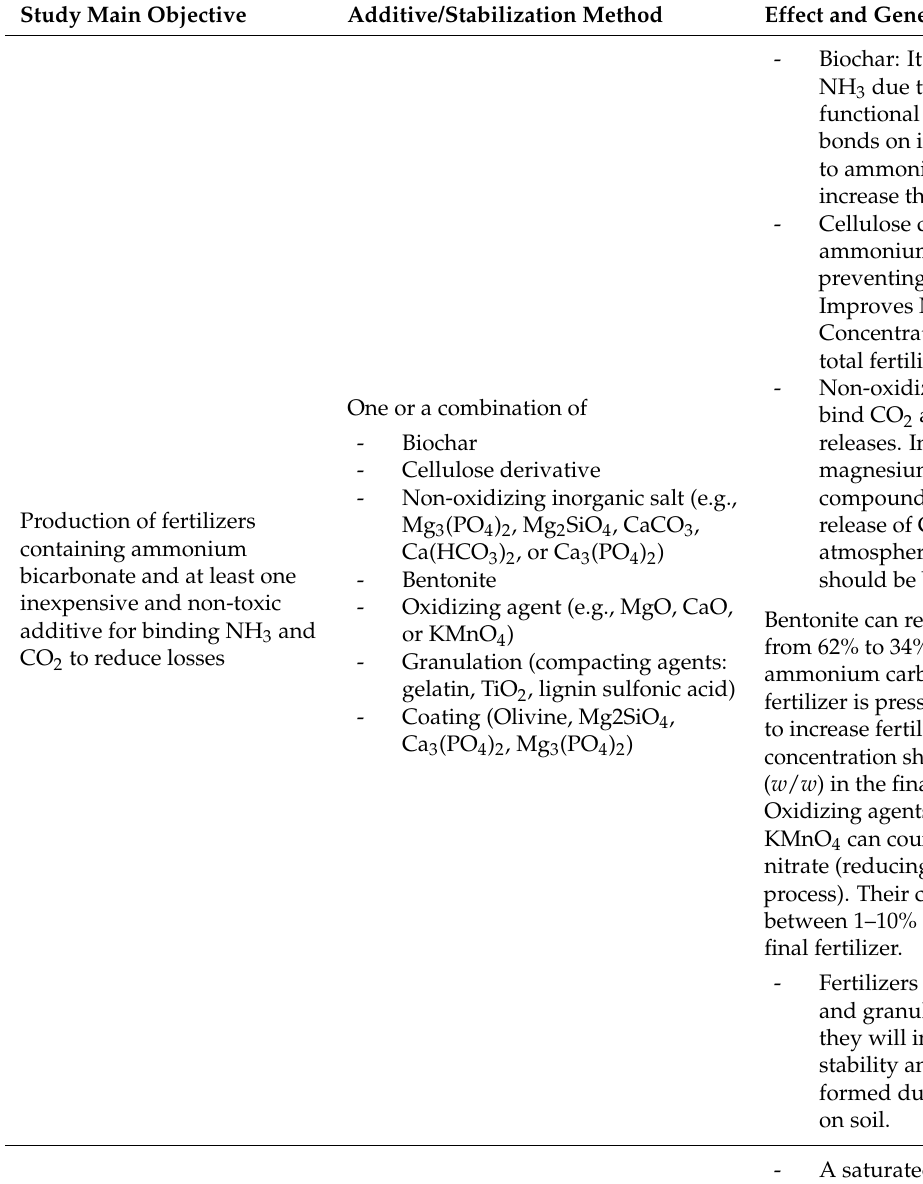
Table 2. Summarized studies to increase ammonium bicarbonate